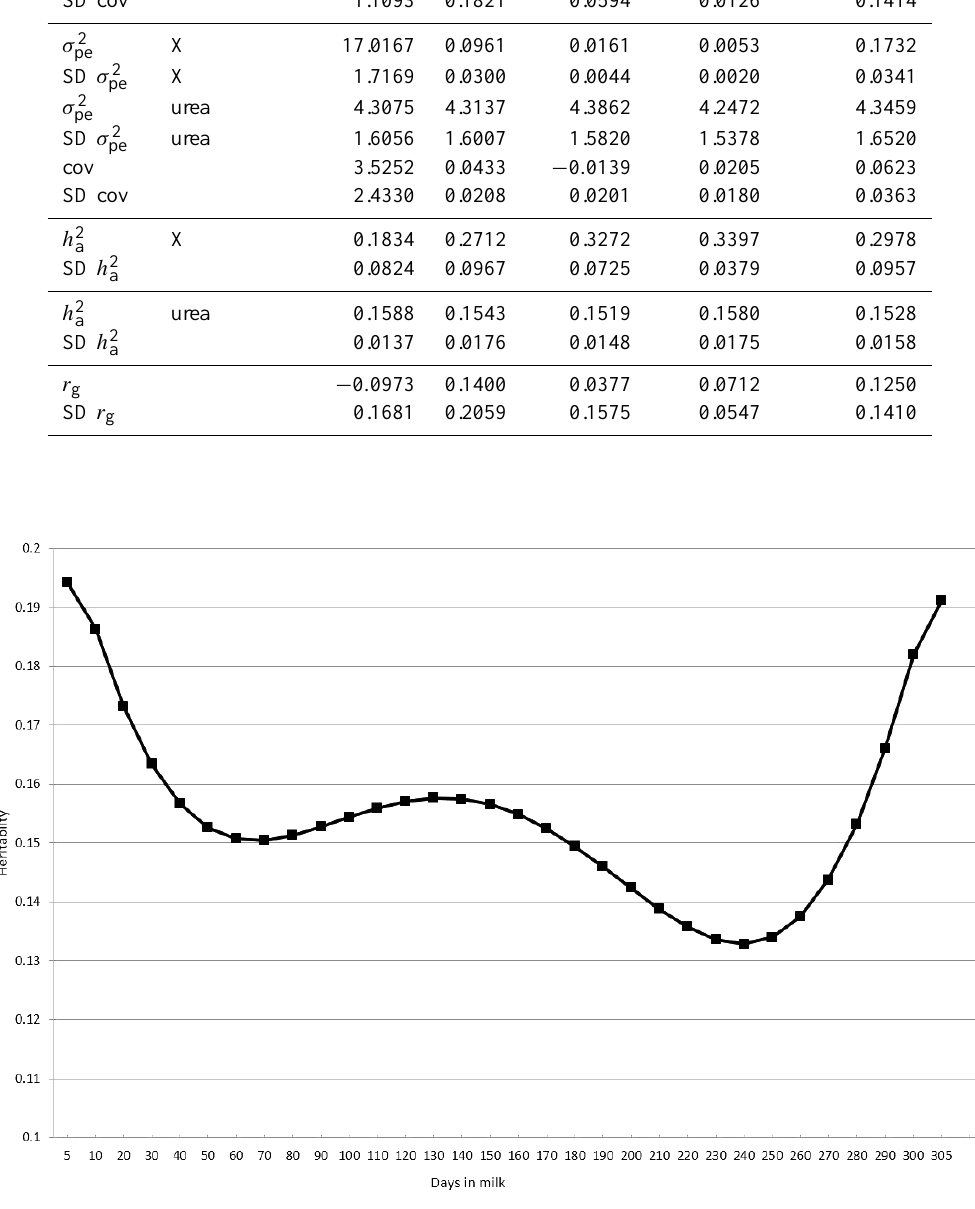
Figure 1. Daily heritability values for